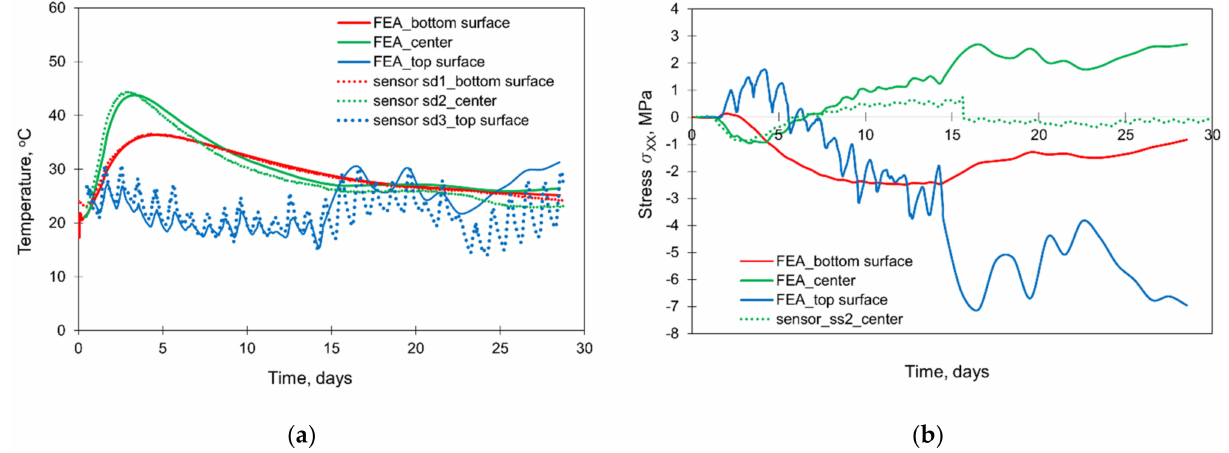
Figure 12. Validation of the FE model: ( a ) temperature development, ( b ) stress development [32–34,42].